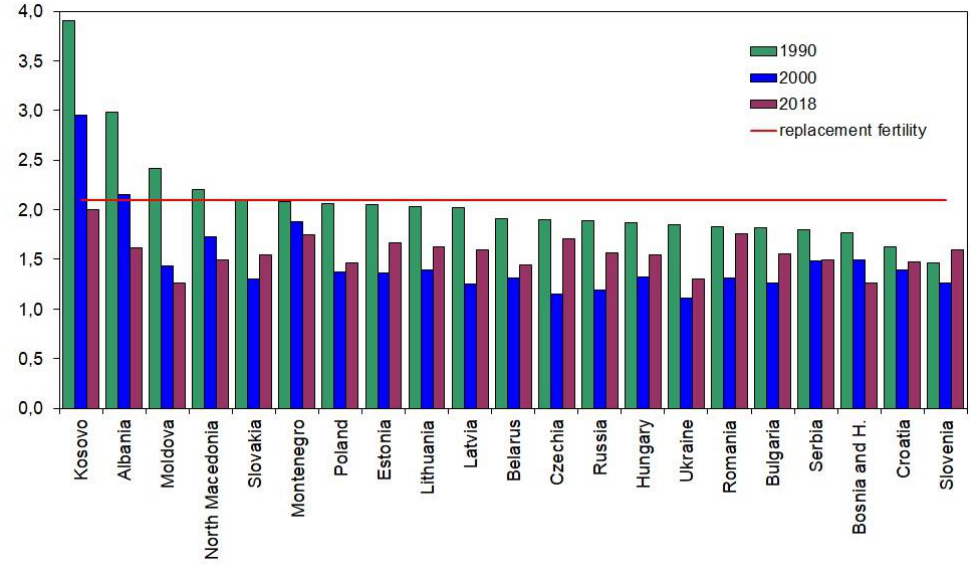
Fig. 6. Total fertility rate (Source: World Bank, 2021) Table 1. Life expectancy at age 60 (years) (Source: World Bank, 2021) Female Male Country